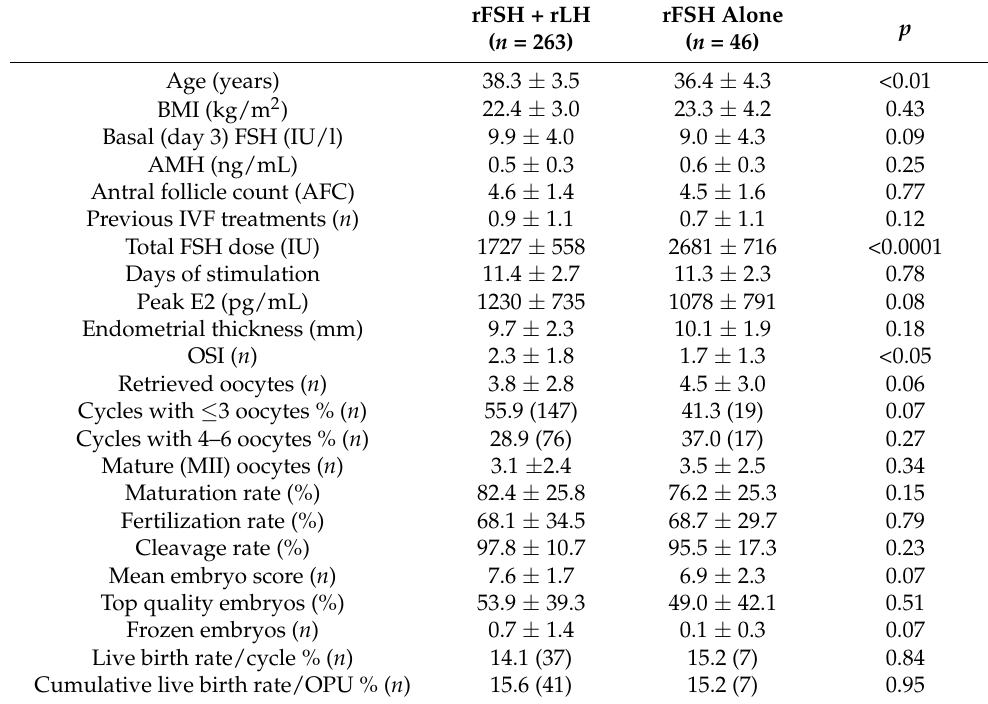
Table 2. Clinical baseline characteristics and IVF outcome of the patients with 6 or less retrieved oocytes (poor or suboptimal responders, n = 309) receiving COS with rFSH + rLH ( n = 263) or rFSH alone ( n = 46). Data are expressed as mean ± standard deviation or as absolute values and percentage, as appropriate.